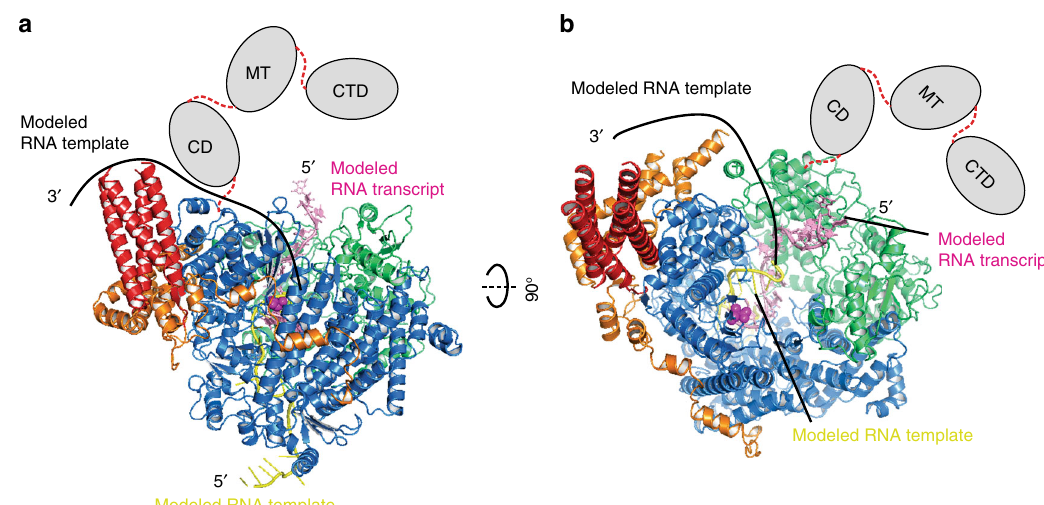
Fig. 4 The proposed model of RSV RNA synthesis. a , b The RSV polymerase with modeled RNA template and transcript (PDB: 6QCV). The same color scheme for RSV proteins as Fig. 2a. The modeled RNA template and RNA transcript are shown in yellow and pink, respectively. (Supplementary Fig. 11 for additional comparisons). The 3 ′ RNA template enters the RdRp from the bottom, and 5 ′ RNA transcript exits from the top. The upstream 3 ′ RNA template is drawn in black